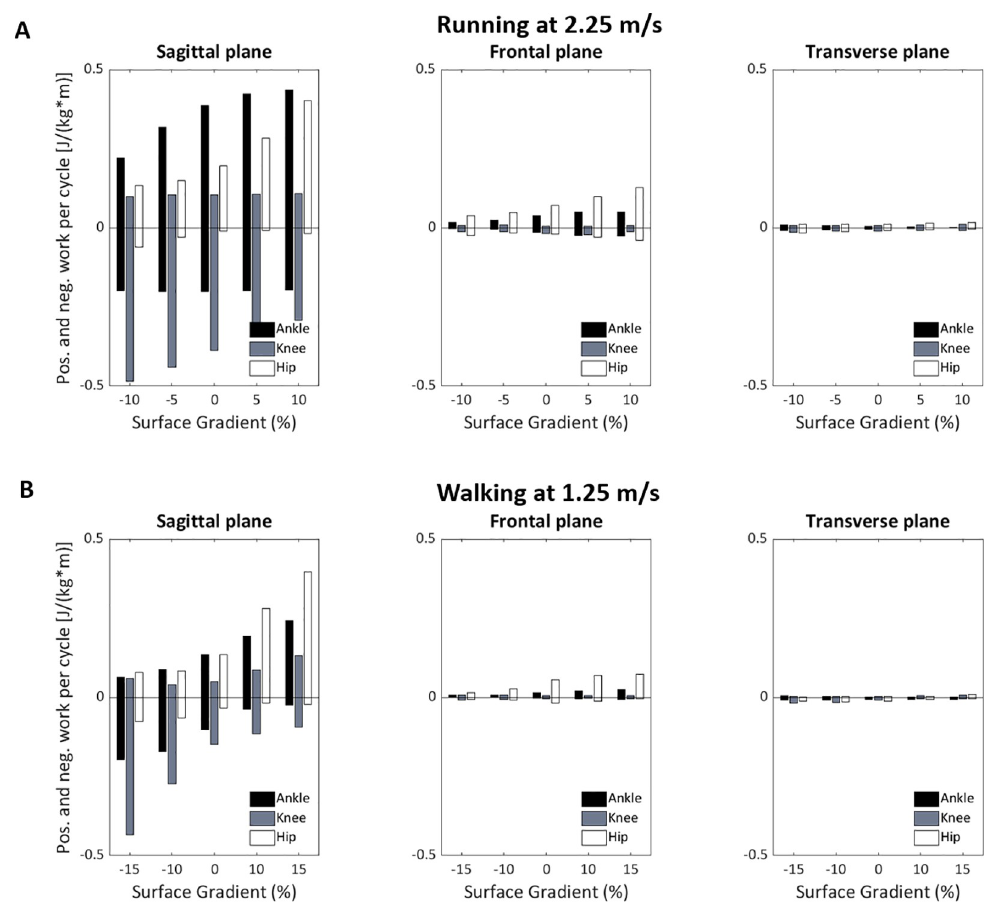
Fig 10. Positive and negative work per stride cycle as a function of the surface gradient in three anatomical planes (top panel: Running; bottom panel: Walking). The bar above zero represents positive work performed in the joint during a stride cycle; the bar below zero represents negative joint